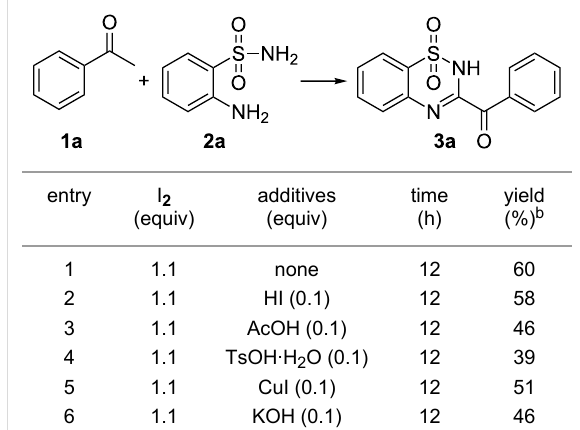
2-aminobenzenesulfonamides and acetophenones via iodine- mediated sp 3 C–H functionalization.